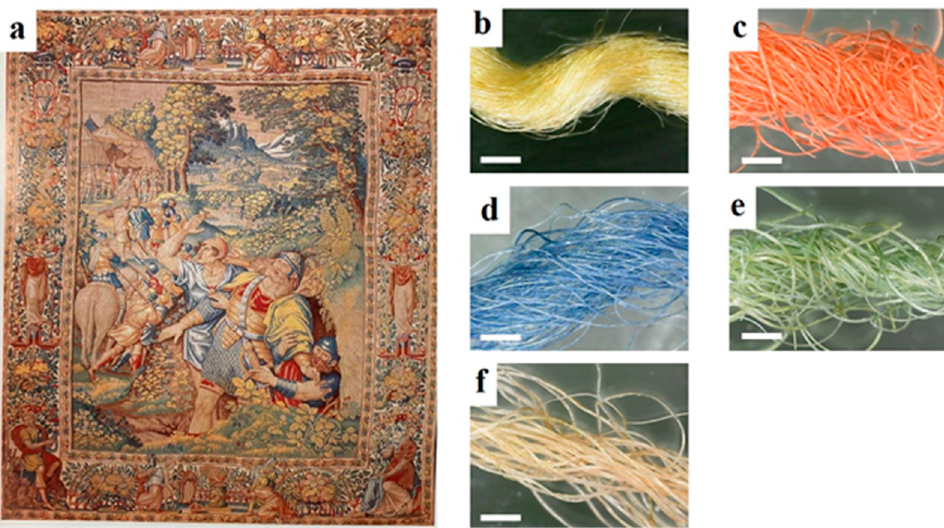
Figure 4. Optical photo of the Flemish Tapestries (348.5 cm × 250 cm) of the Sixteenth Century ( a ) and optical micrographs of yarns: yellow weft ( b ), red warp ( c ), blue warp ( d ), green warp ( e ) and brown warp ( f ). Scale bars are 1 mm.